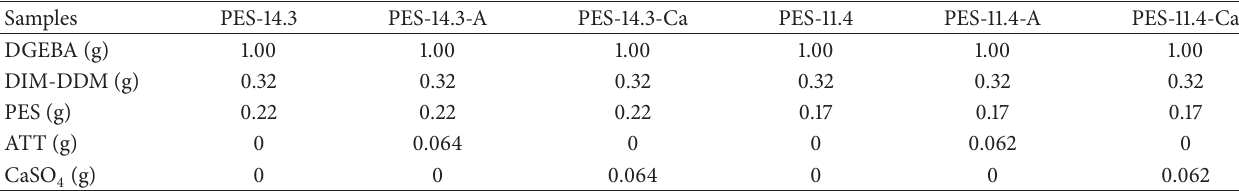
Table 1: The weight compositions of the samples